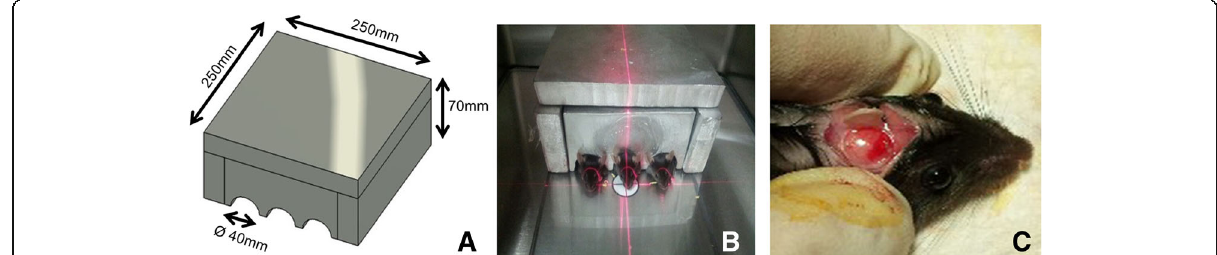
Fig. 1 a Design of lead shielding block for selective irradiation to the head region. b Mice were adapted to a digital X-ray equipment Faxitron with radiation shield. c Two weeks after the irradiation, mouse calvaria defect was created. Collagen scaffold with or without rhBMP-2 was applied over the mouse calvarial